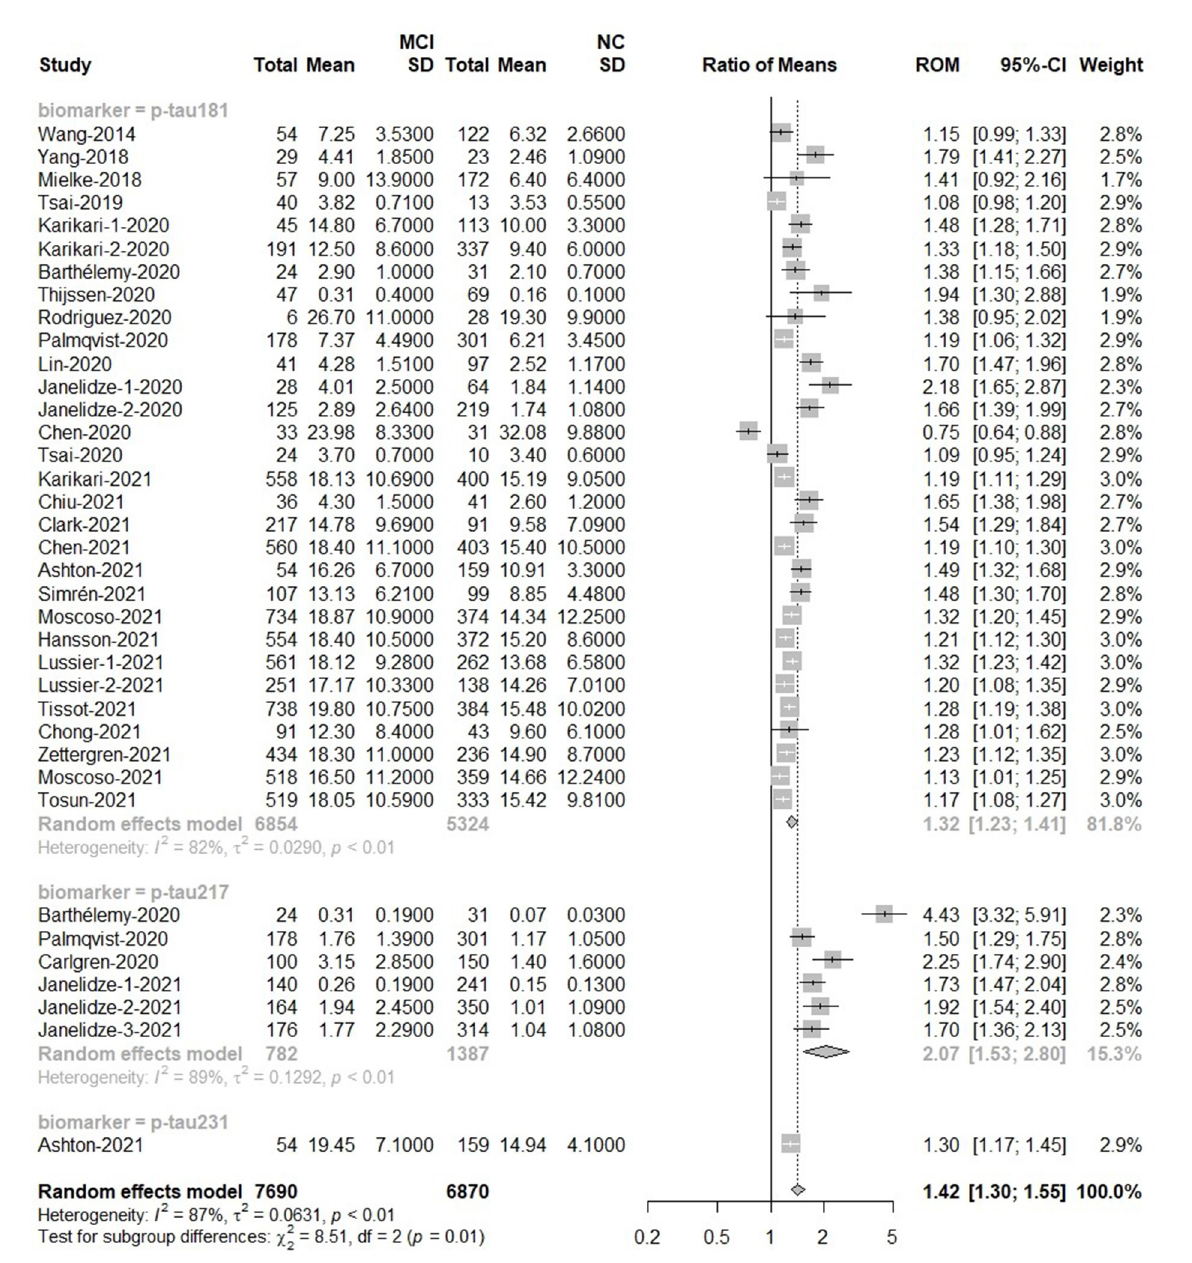
FIGURE3 MCI to control ratio for blood p-tau: Forest plot of the ROMs (with 95%CI) for each tau subtype between MCI and normal cognitive controls. A ROM above one means that p-tau proteins were elevated in the MCI groups. Total, total sample size; Mean, mean value; SD, standard deviation; ROM, ratio of means; CI, confidence interval; MCI, mild cognitive impairment; NC, normal cognitive.